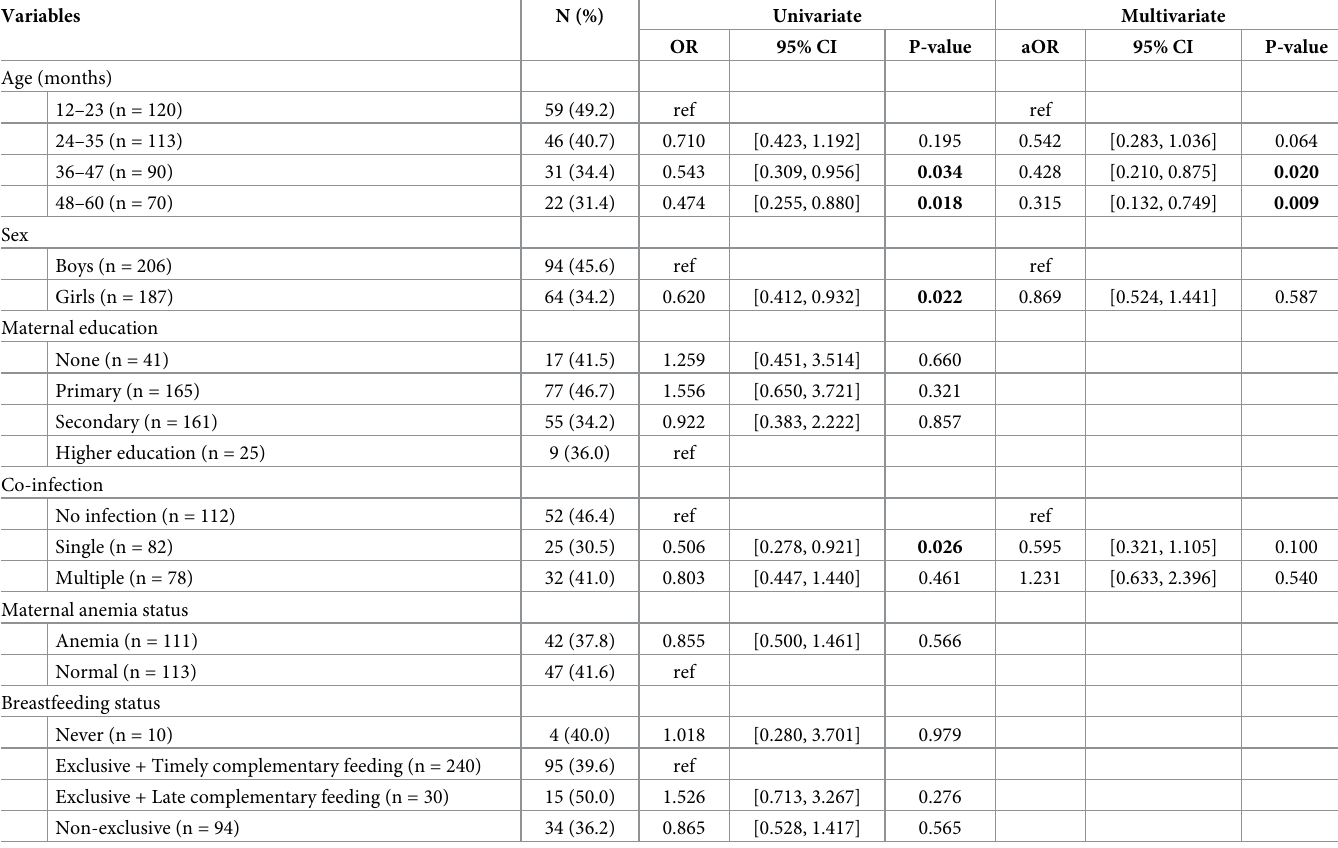
Table 3. Factors associated with height-for-age Z-score (HAZ) among preschool-age children (PSC) in this study (n = 393).